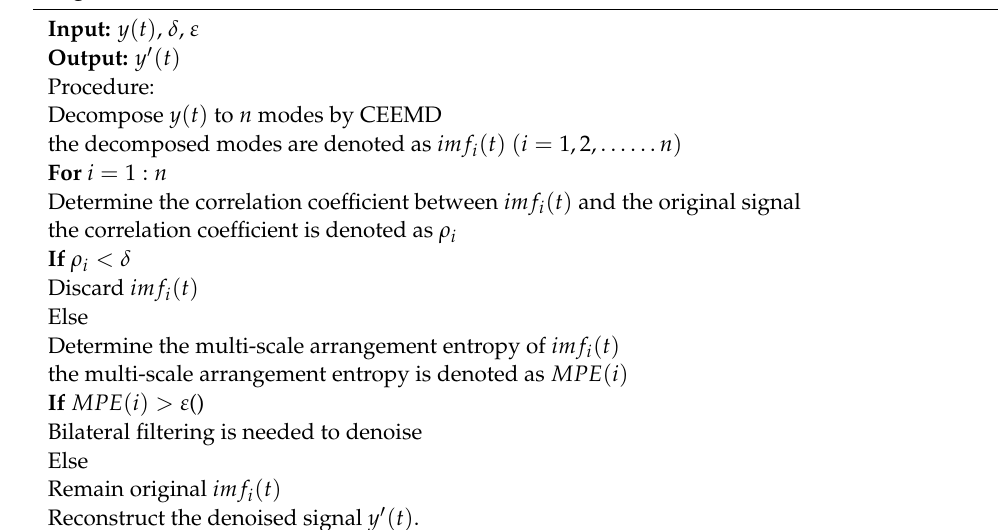
Algorithm 1: The workflow of new